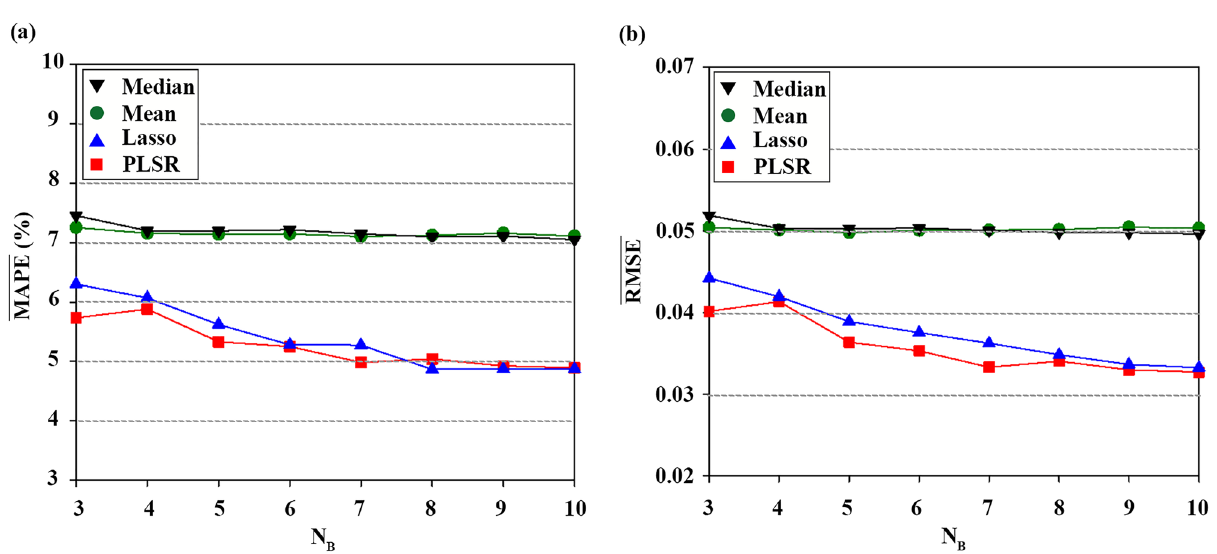
Figure 5. Forecasting accuracy of LSTM-based ensemble model according to number of base models (N B ): ( a ) MAPE (%) for different meta models, ( b ) RMSE for different meta